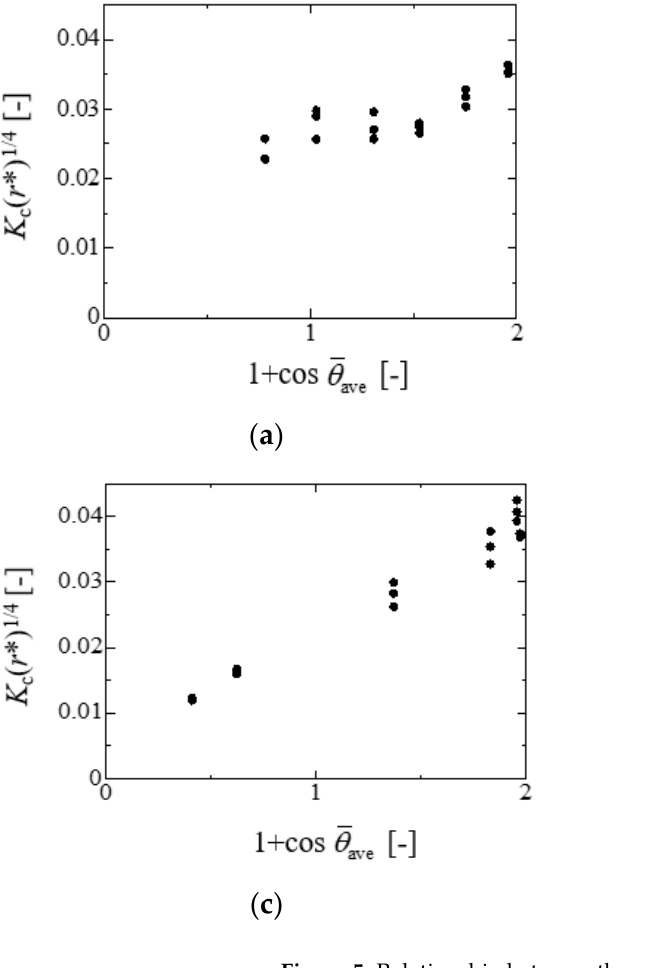
( d ) Figure 7. Relationship between 1+cos ave θ and the mass concentration of ethanol: ( a ) bare substrate; ( b ) #400 substrate; ( c ) #240 substrate; and ( d ) #120 substrate. The error indicates two standard devi- ation (2SD).